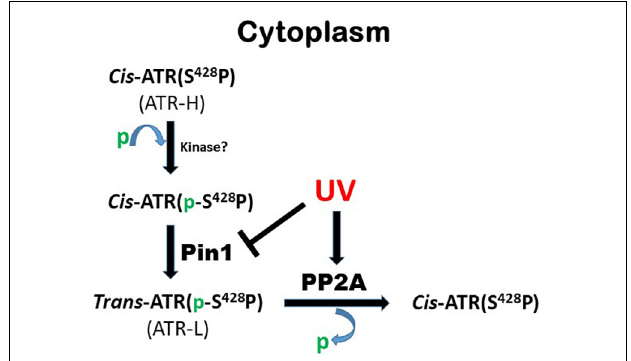
FIGURE 6 | Summary of role of PP2A in Pin1-mediated ATR isomerization in the